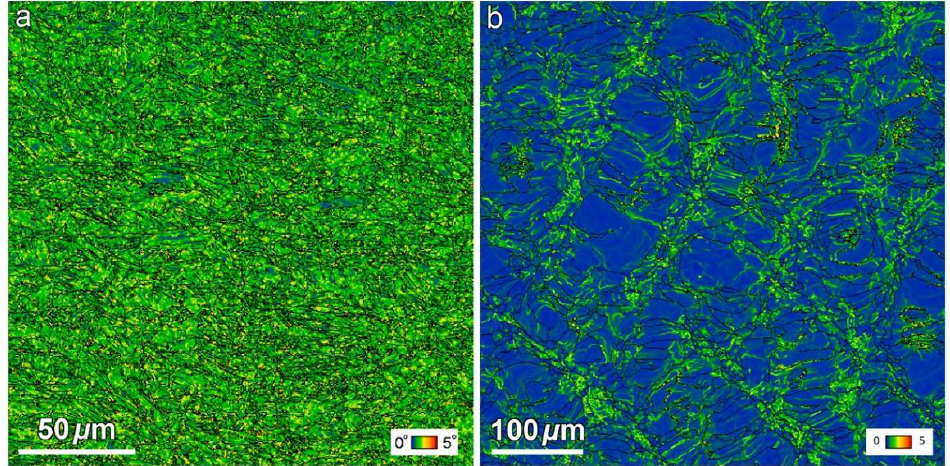
Figure 11. KAM results of the as-built PH17-4 PHSS with ( a ) martensitic microstructure and ( b ) ferritic microstructure [158]. (Adapted from Ref.